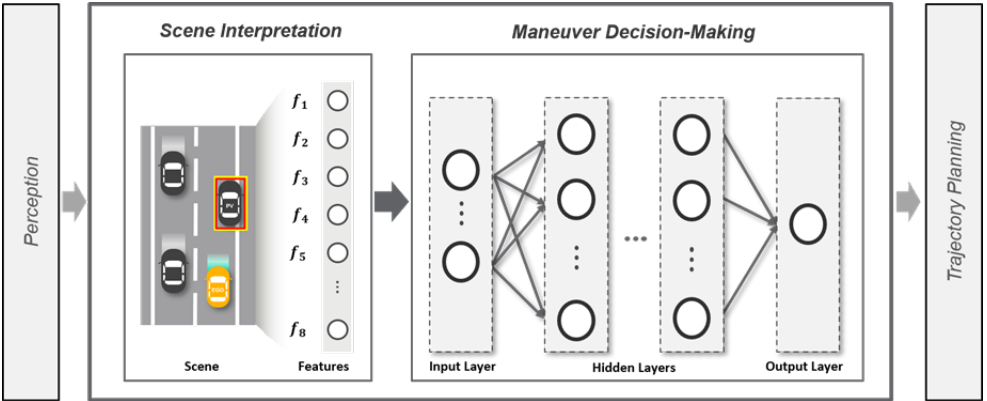
Figure 2. System architecture of the proposed decision-making system for overtaking